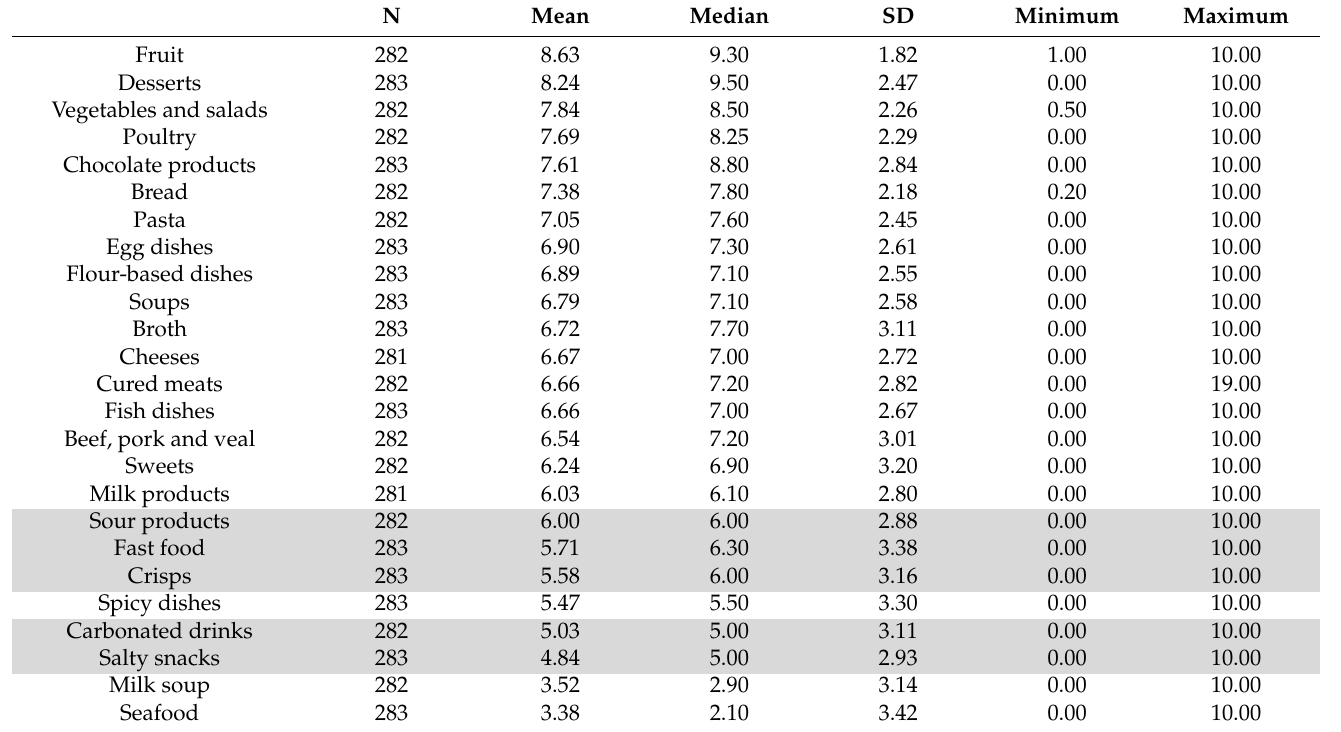
Table 2. The values of the declared pleasure of eating various types of dishes, ranging from the most popular ones. Dishes marked in grey are the ones that have been identified by statistical analysis as a common ‘unhealthy food with a strong flavour’ group.